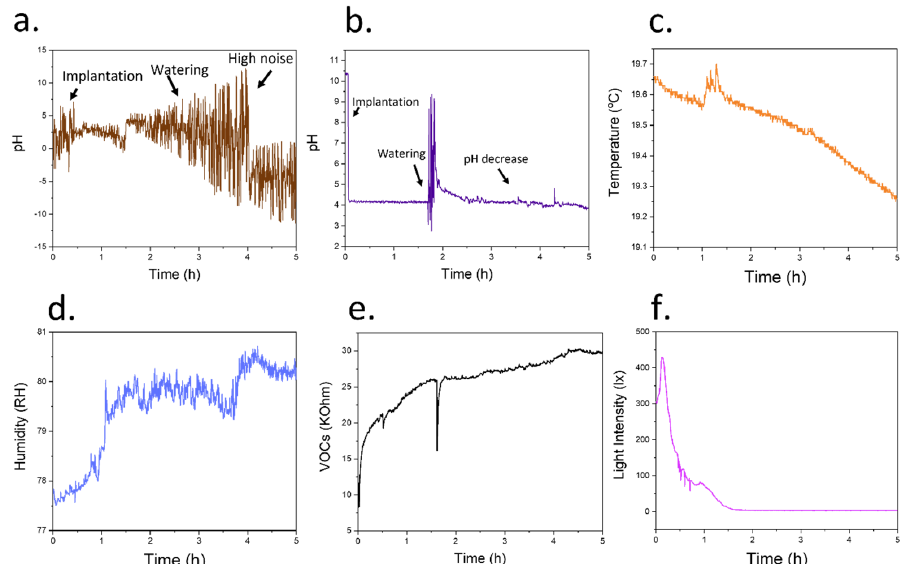
Figure 7. ( a ) Measurement of pH inside the tomato stems using a pristine electrode without the incorporation of a cellulose-based coating. An increasing noise was recorded, with a change upon watering the plants. ( b ) Plot obtained after the recording of pH in a tomato stem using cellulose-based device. The changes in pH upon watering the tomato plant could be determined. In particular, a stable decrease in pH after the watering was obtained. ( c ) The use of a BME680 sensor allowed the determination of environmental temperature. ( d ) The humidity of the devices was additionally measured, evidencing an increase after watering the plant with DI water. This humidity could be used to indicate the water needs from the plant. ( e ) The concentration of VOCs could additionally be assessed through the determination of the resistance of a metal oxide-based gas sensor. In this case, lower values of resistance represent a higher concentration of VOCs. These results indicate a lower concentration of VOC concentrations after watering the plant. ( f ) The Wio Terminal device used within the present work incorporated a light sensor that could be used for the study of day/night cycles in plants. The recorded intensity decreased up to 0 after a few